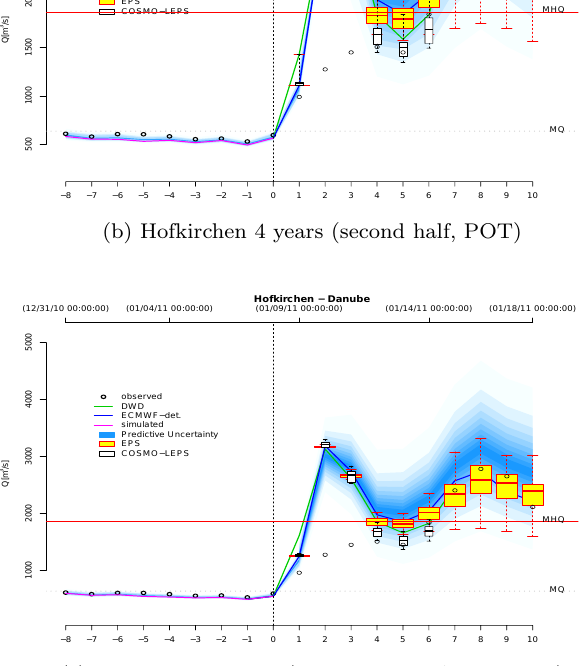
Fig. 6. Corrected forecast at station Hofkirchen including extreme values for extrapolation based on (a) four years of the first half, including several severe events and (b) four years of the second half (less severe events) and (c) four years of the second half sample combining the GAM and the POT model for